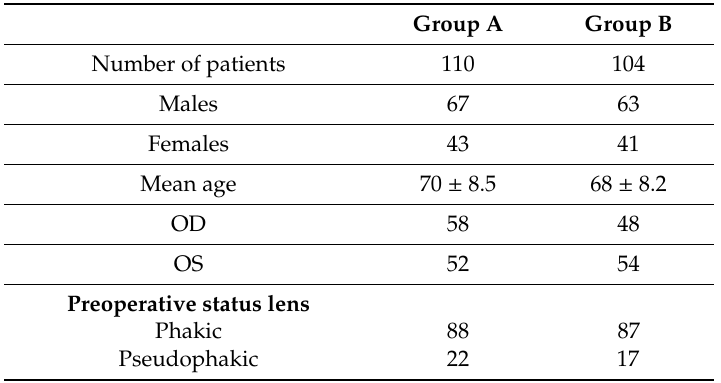
Table 2. Table of demographic data and preoperative status of the two